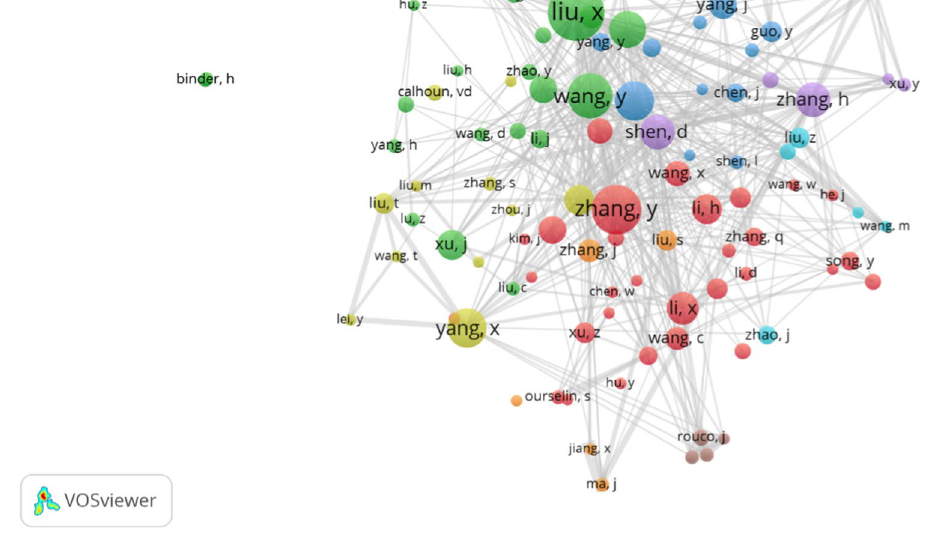
Fig. 10 Author bibliographic coupling network of MMDLM- related publications